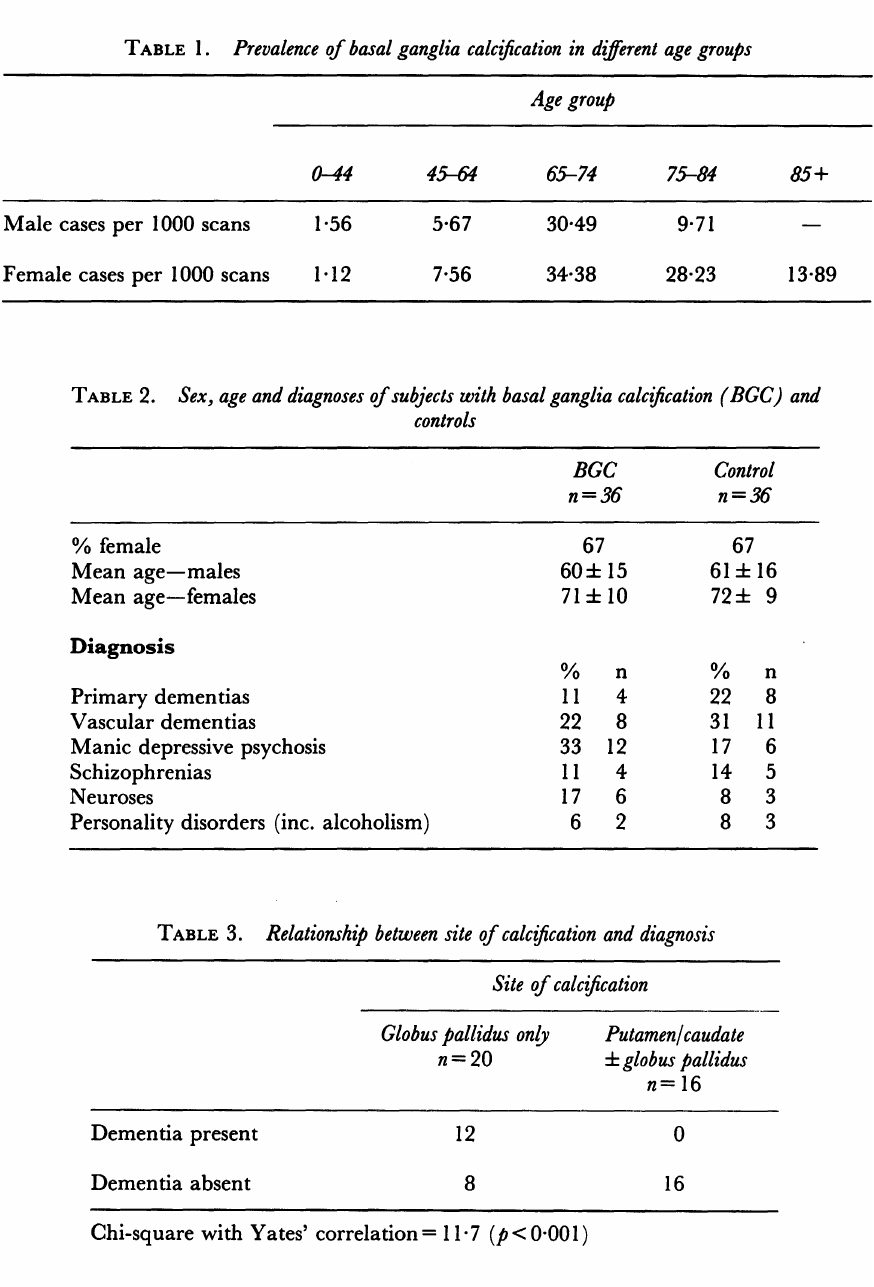
TABLE I. Prevalence qf basal ganglia calcification in different age groups